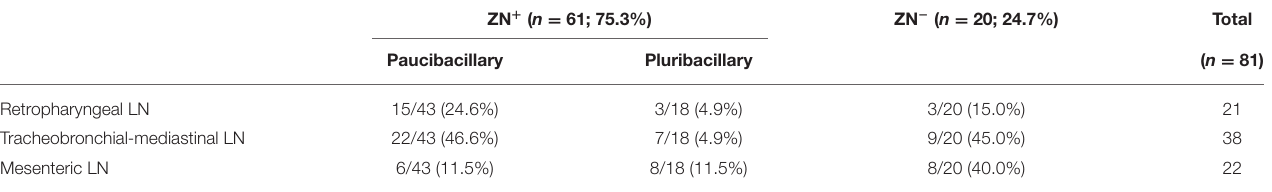
TABLE 5 | Classification of the lesions according to the Ziehl-Neelsen (ZN) staining and the number of AFB, paucibacillary or pluribacillary, in the different lymph nodes. ZN + ( n = 61; 75.3%)